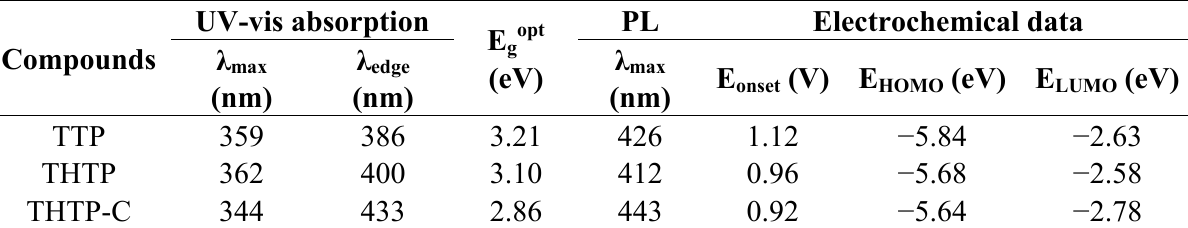
Table 1. Optical and electrochemical data in thin